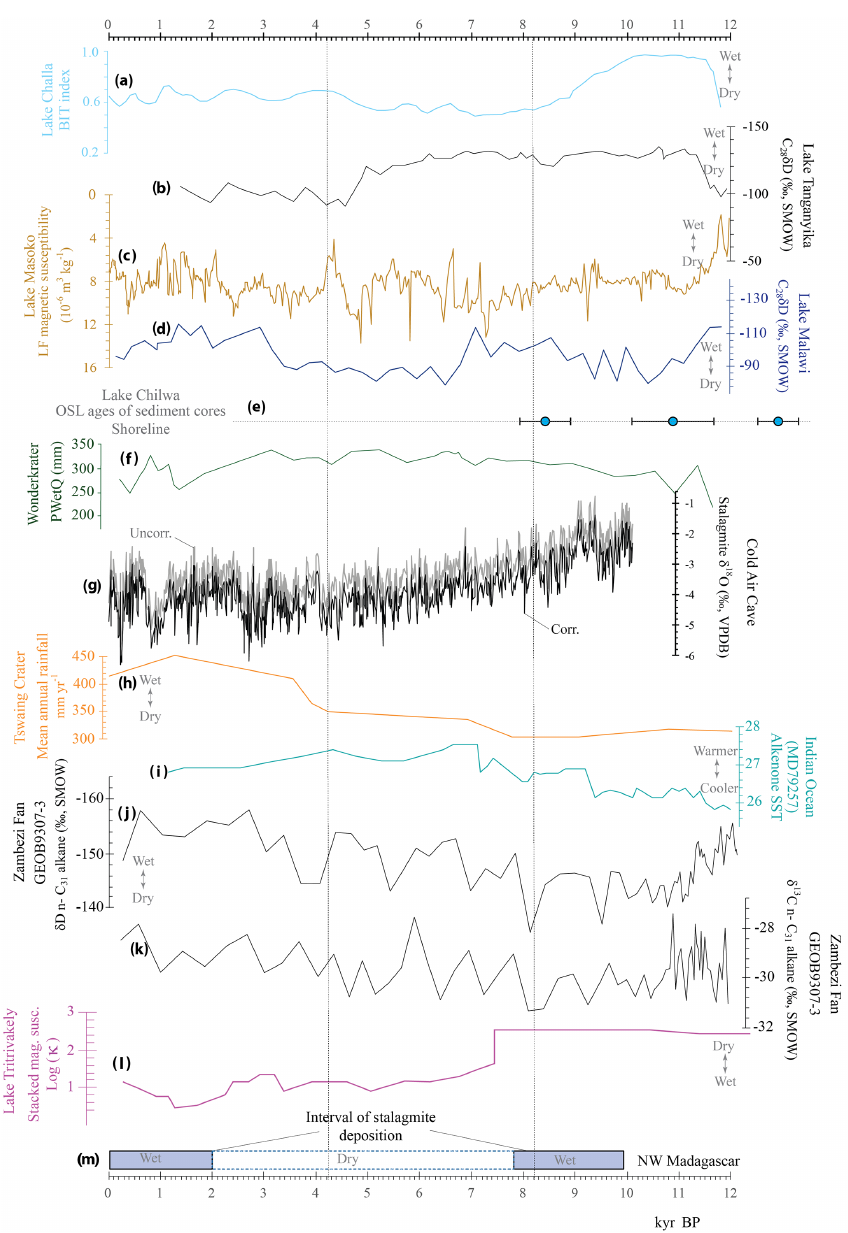
Figure 9. Regional comparison. (a) Lake Challa BIT index (Verschuren et al., 2009). (b) Lake Tanganyika C 28 δ D (Tierney et al., 2008, 2010). (c) Lake Masoko low field magnetic susceptibility (10 − 6 m 3 kg − 1 ) (Garcin et al., 2006). (d) Lake Malawi C 28 δ D (Konecky et al., 2011). (e) Lake Chilwa OSL dates of shoreline (Thomas et al., 2009). (f) Wonderkrater reconstructed paleoprecipitation, PWetQ (precipitation of the wettest quarter; Truc et al., 2013). (g) Cold Air Cave corrected (corr.) and uncorrected (uncorr.) δ 18 O profiles from Stalagmite T8 (Holmgren et al., 2003). (h) Tswaing Crater paleorainfall derived from sediment composition (Partridge et al., 1997). (i) Indian Ocean SST records from alkenone (Bard et al., 1997; Sonzogni et al., 1998). (j–k) Zambezi δ D n-C 31 alkane and δ 13 C n-C 31 alkane (Schefuß et al., 2011). (l) Lake Tritrivakely stacked magnetic susceptibility (Williamson et al., 1998). (m) NW Madagascar (Anjohibe and Anjokipoty) interval of deposition of Stalagmite ANJB-2 and Stalagmite MAJ-5 (this study). The two vertical dashed lines indicate the boundary of the early, middle, and late Holocene by Walker et al. (2012) and Head and Gibbard